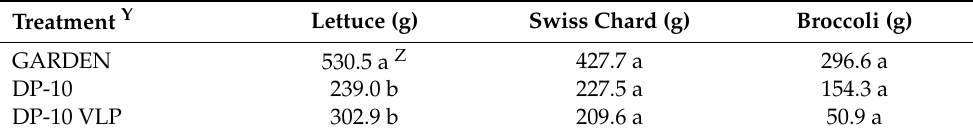
Table 6. Cumulative yield of vegetables grown in seven at-home trials in